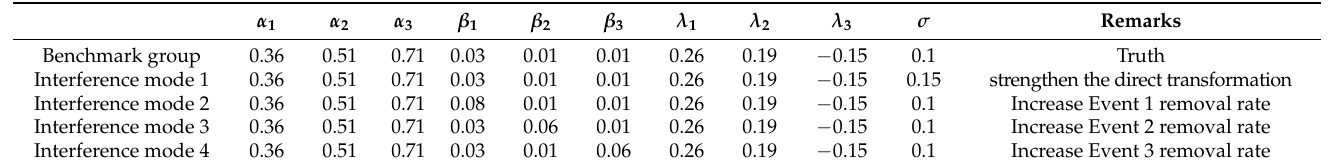
Table 6. Parameter settings considering effects of government on relevant public